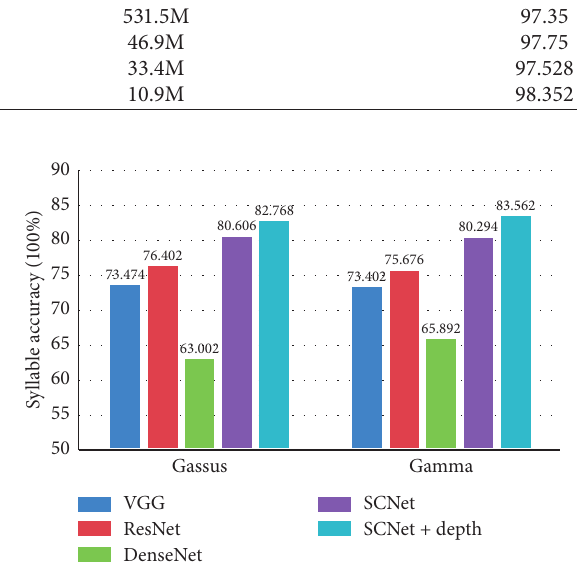
Table 3: Comparison of the network depth, parameters and experimental accuracy of the four different models. Method